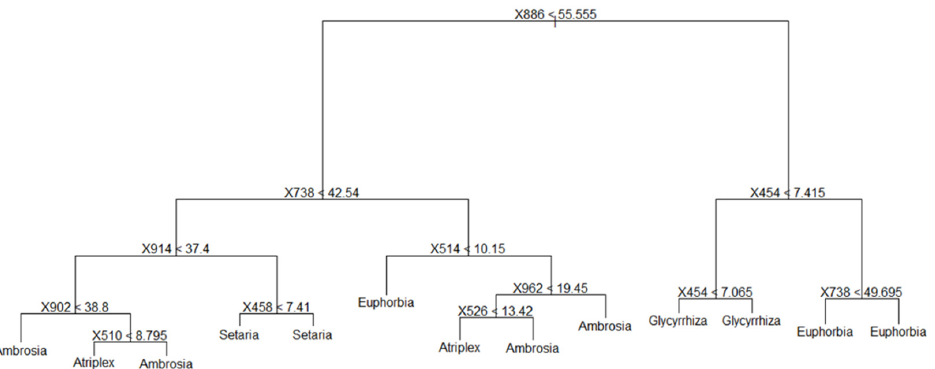
Figure 14. Wavelength DT for Ambrosia artemisiifolia , Atriplex tatarica , Glycyrrhiza glabra , Euphorbia seguieriana , and Setaria pumila . Table 11. The value of the dispersion of the main components of the projection at wavelengths